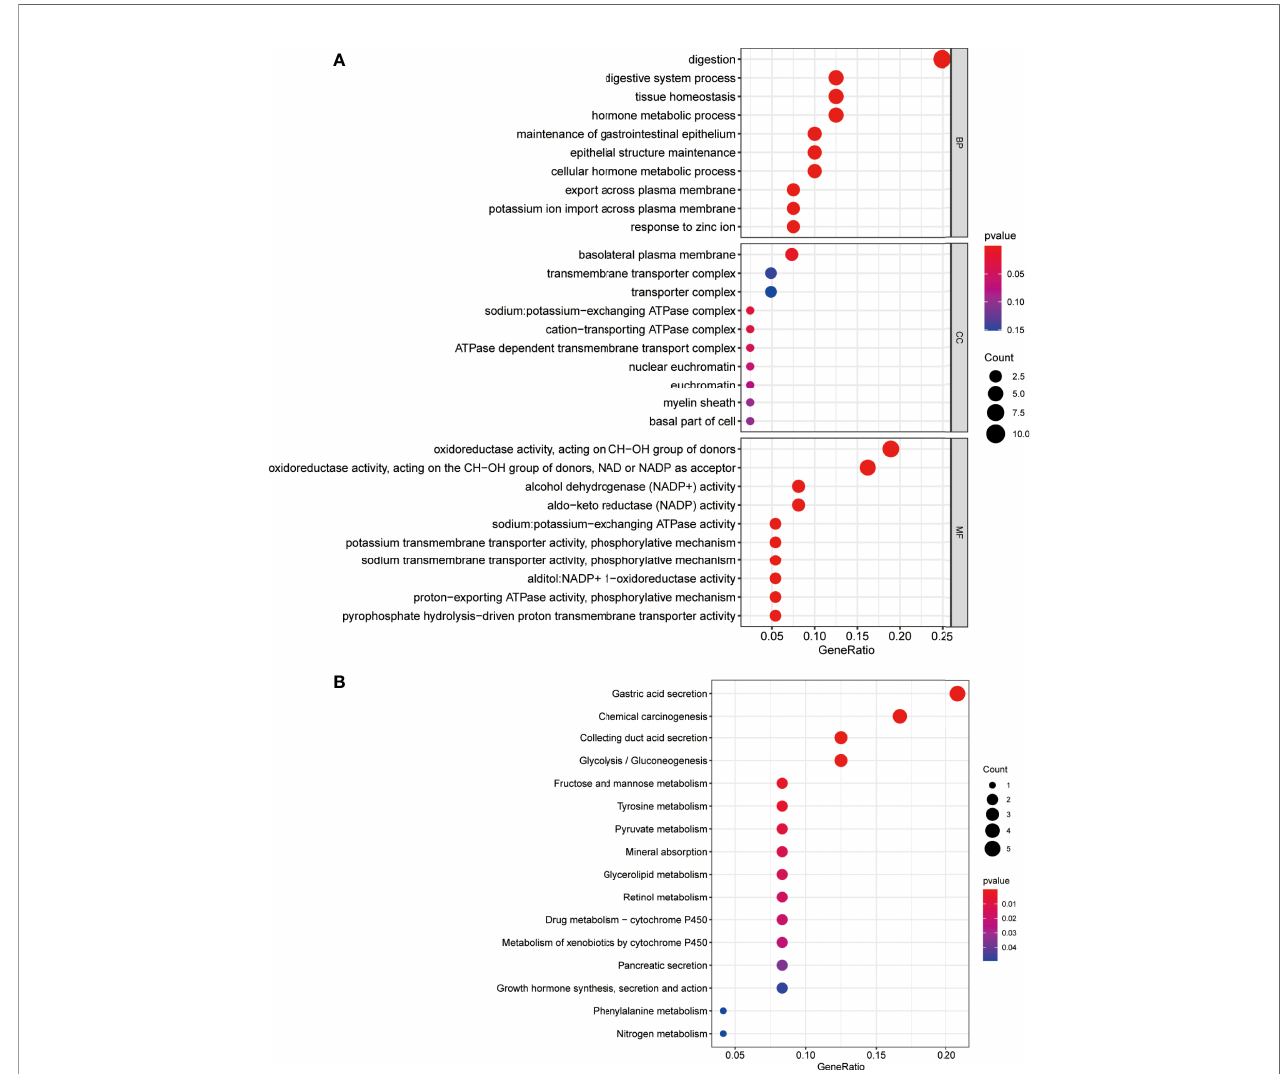
FIGURE 5 | Enrichment analysis for the genes. (A) The bubble chart of GO enrichment analysis. (B) KEGG signal pathway analysis. The color represents the adjusted P -values (BH), and the size of the spots represents the gene